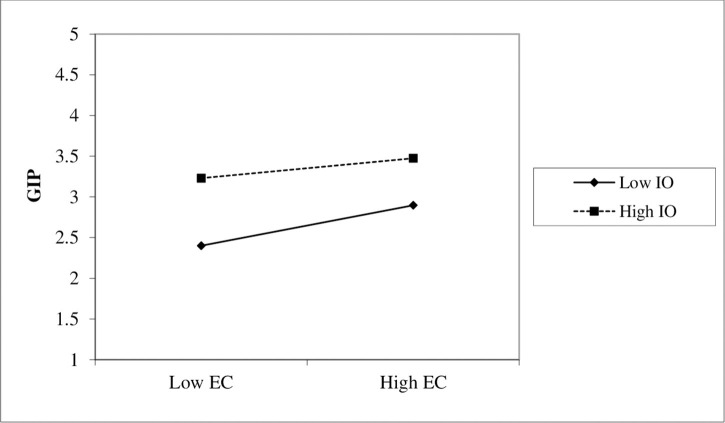
Interaction graph EC × IO and GIP.